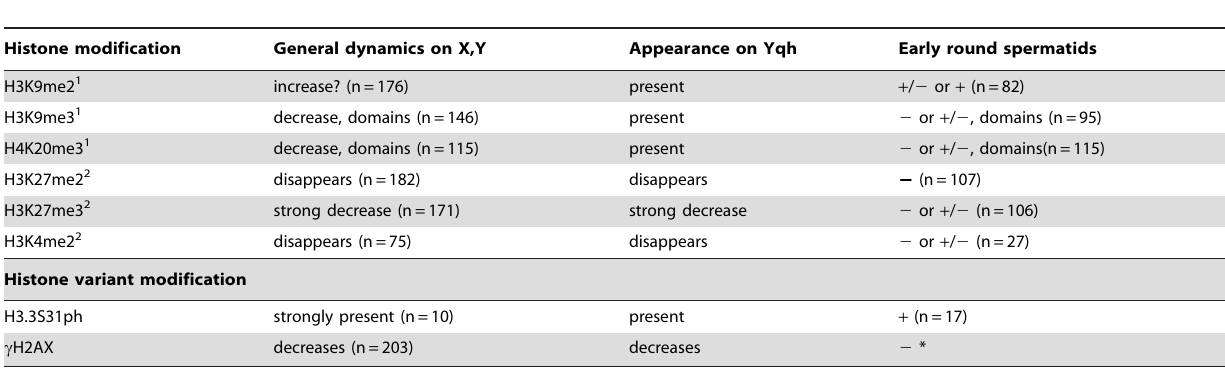
Table 2. Histone variant- and histone N-tail-modification dynamics at meiotic and post-meiotic X,Y